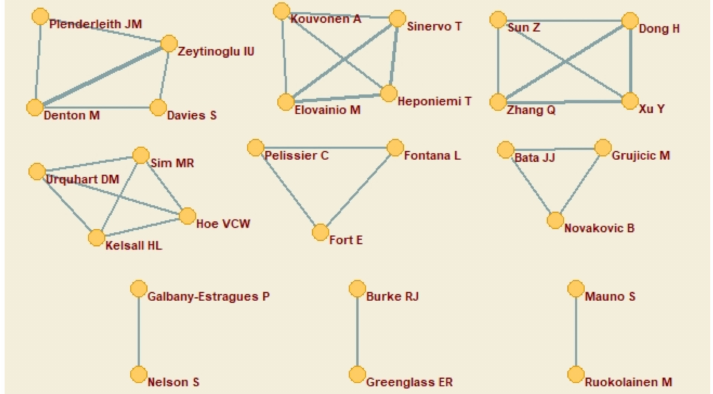
Figure 2. Co-author network.